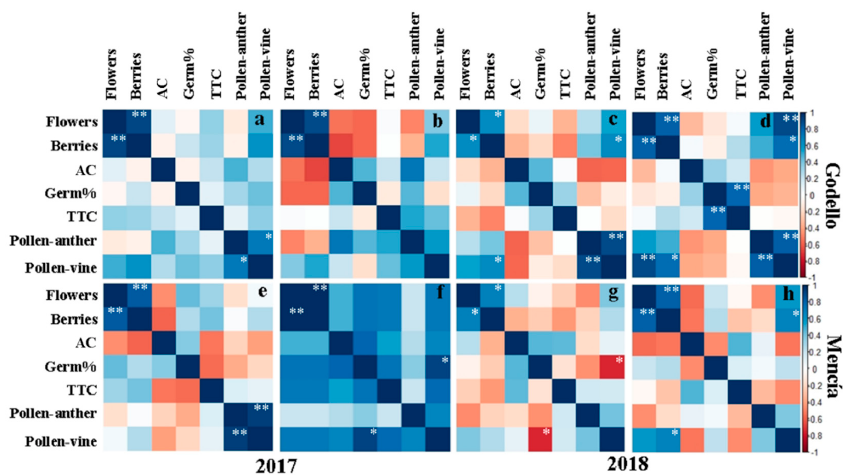
Figure 7. Spearman’s rank correlation matrix coe ffi cients between flower and berry number, pollen grains’ viability by means of aceto-carmine (AC) and 2, 3, 5-triphenyltetrazolium chloride (TTC), germination rate, and pollen production per anther and vine. Squares a, b, c, and d correspond to Godello variety, and the squares e, f, g, and h to Menc í a. The four left squares correspond to 2017 and the four right squares to 2018. Godello in: ( a ) Cenlle 2017, ( b ) Souto 2017, ( c ) Cenlle 2018, ( d ) Souto 2018; Menc í a in: ( e ) Doade 2017, ( f ) Souto 2017, ( g ) Doade 2018, ( h ) Souto 2018. Coe ffi cient values were expressed as colors (legend in the right of the graphs), and significance level was represented as * p < 0.05, ** p < 0.01.